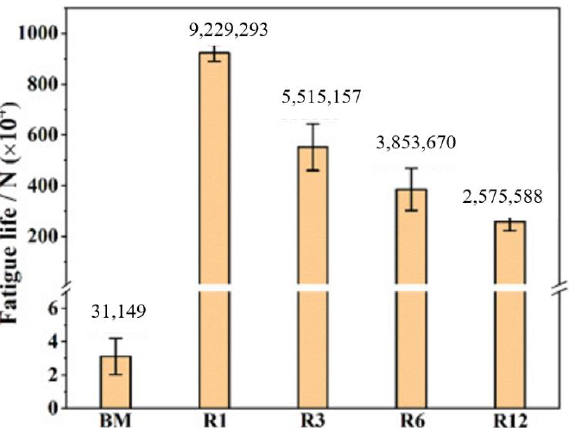
Figure 10. The fatigue of life of USRP ’ ed Ti6Al4V specimens under a stress value of 700 MPa. Reproduced with permission from [59]. Copyright 2019 Elsevier.